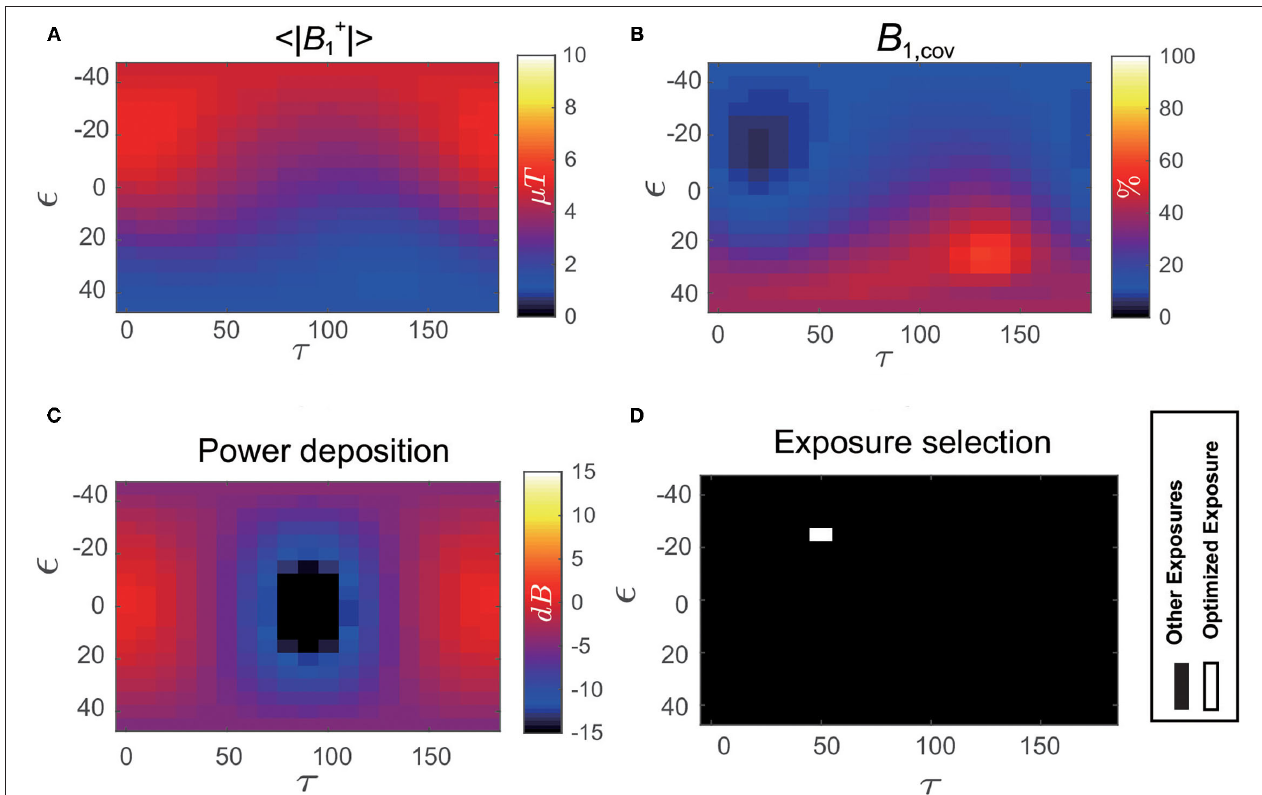
FIGURE 7 | (A) Distribution of B + 1 magnitude averaged over the iso-center slice of Duke as a function of B 1 polarization ( ǫ , τ ). (B) Distribution of B + 1 coefficient of variation B + 1, cov over the iso-center slice of Duke as a function of B 1 polarization ( ǫ , τ ). (C) Distribution of in vivo power deposition ( P dep ) of the implant under test (IUT) implanted inside Duke as a function of B 1 polarization ( ǫ , τ ). (D) Optimized exposure condition using the exposure optimization procedure performed on Duke under selected clinical scenario is shown as